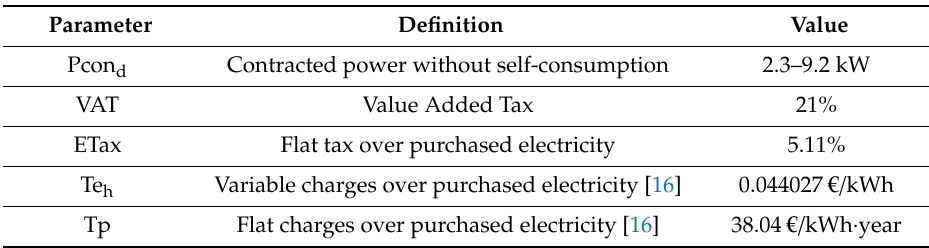
Table 8. Parameters related to the energy billing.